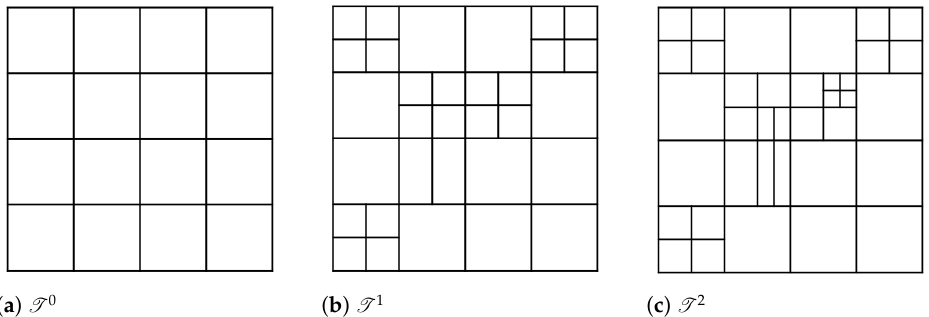
Figure 2. An example for the refinement process of a modified hierarchical